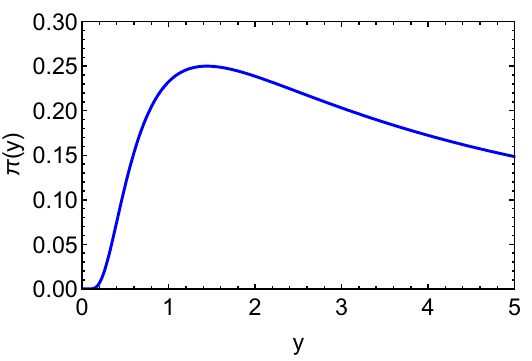
Figure 3 . The function (cid:25) ( y ) that determines the position of the upper boundary (see eq. (3.6)). We assumed l = l target-det det